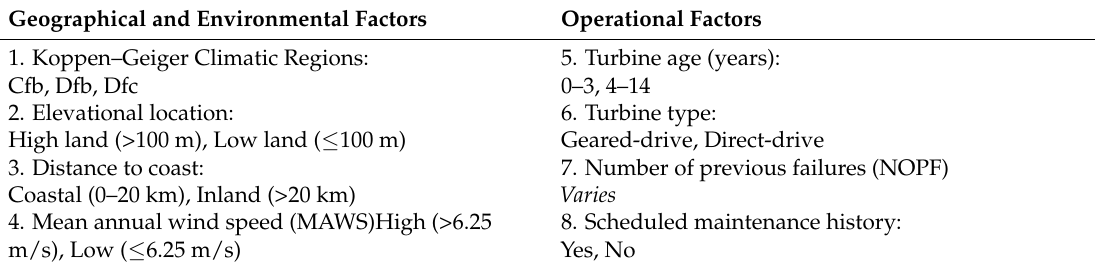
Table 1. Factors considered in the survival